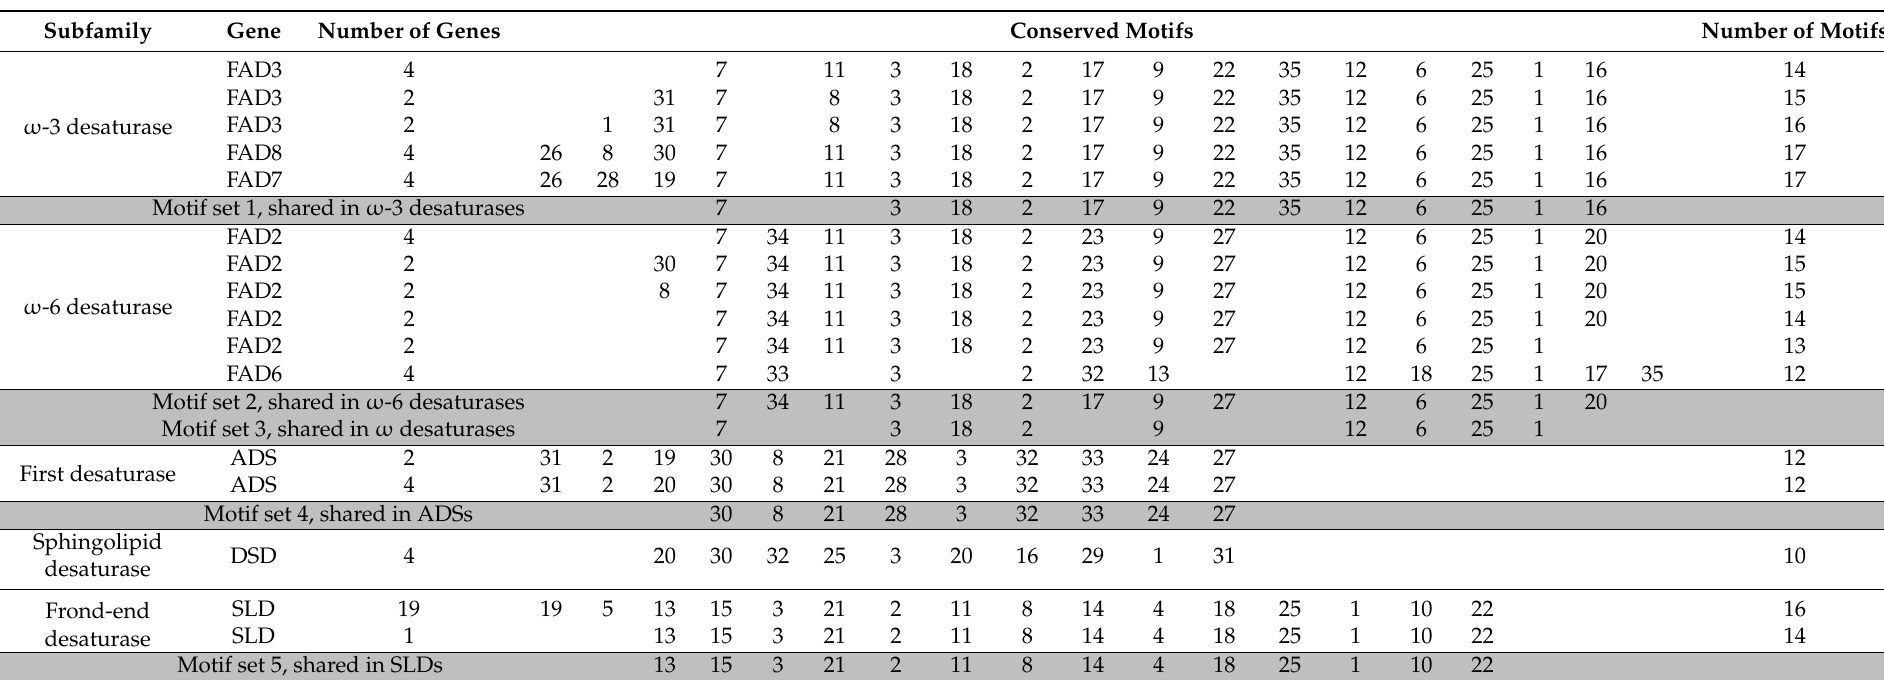
Table 1. Conserved motifs and conserved motif sets of ω -3 desaturases, ω -6 desaturases, ω desaturases, ADSs (first/Arabidopsis desaturases), DSDs (sphin- golipid/dihydroceramide desaturases) and SLDs (front-end desaturases/sphingoid long-chain bases at ∆ 8 desaturases), respectively (shaded